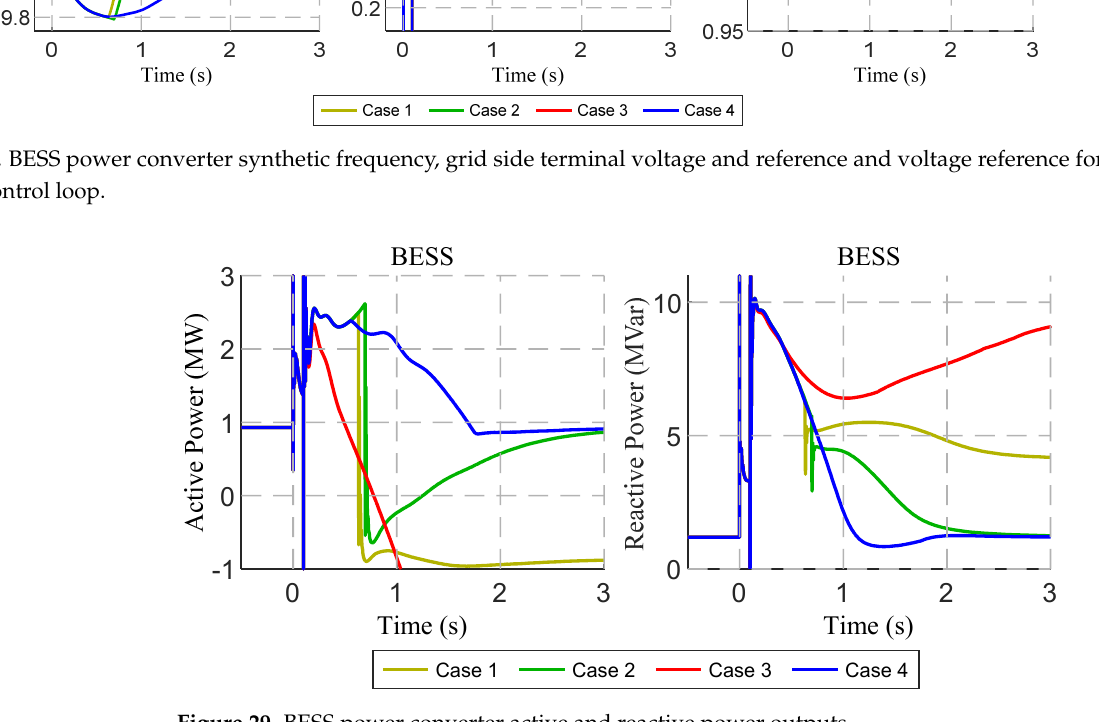
Figure 30. L3 large industrial motor (left) and refrigerator type motors (right) speeds and terminal voltages: influence resulting from different parametrizations of the VSM voltage reference genera- tor. 5.2.2. Robustness Analysis A robustness analysis is presented, similar to the analysis performed in Section 5.1.2, aiming to validate the proposed BESS power converter voltage control strategy (presented